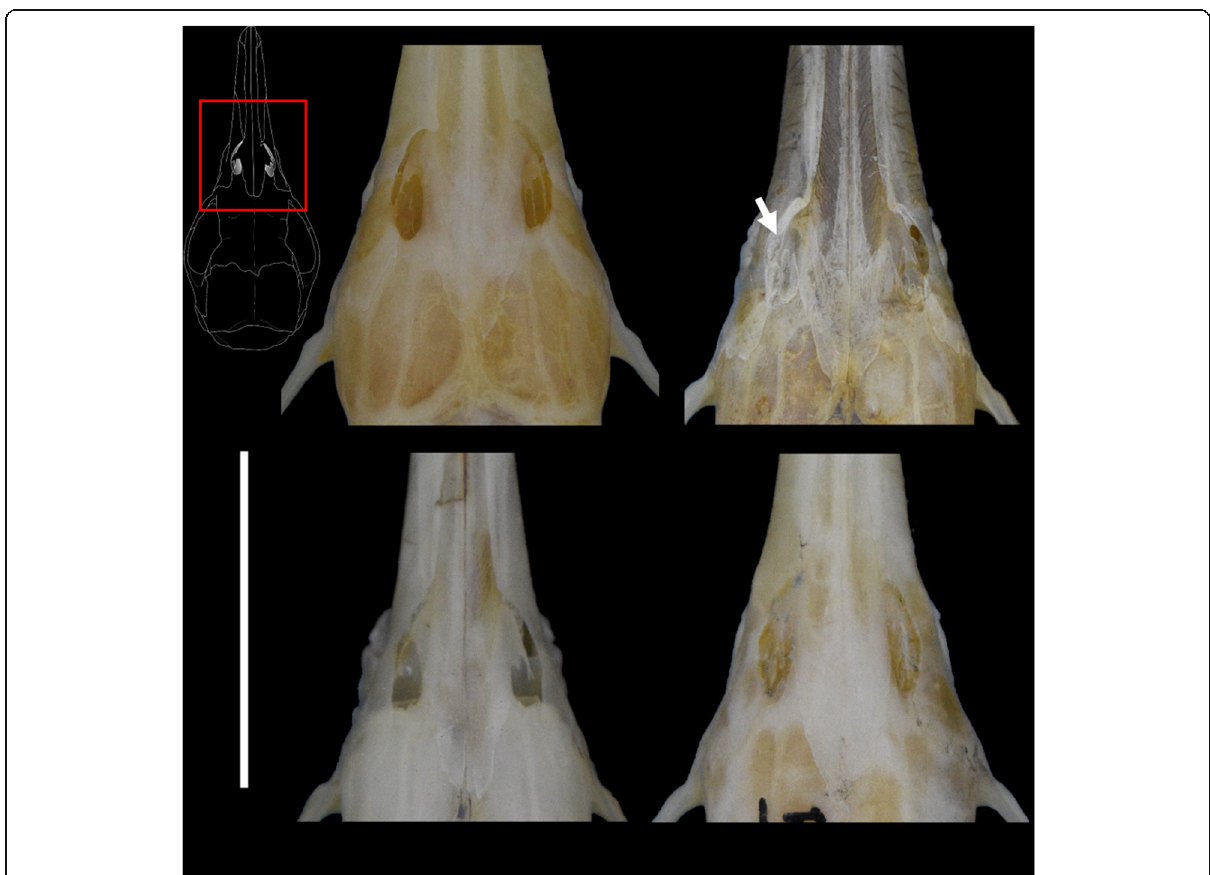
Fig. 2 Differences in ossification patterns in the anteorbital vacuity in Rhyncholestes raphanurus Osgood, from a thin bony cover (top left, FMNH 129823 ♂ ), a left closed vacuity in specimen FMNH 127475 ♂ (top right, white arrow), to partially and fully open in the bottom specimens (FMNH 129834 ♀ , FMNH 129828 ♀ ). Scale bar: 1